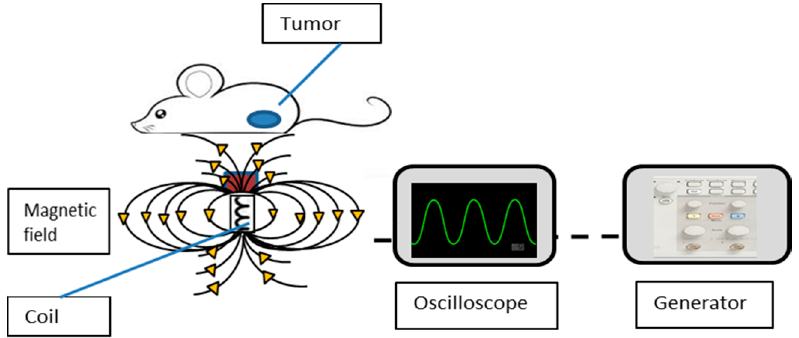
Figure 1. Schematic design of the experimental setup.